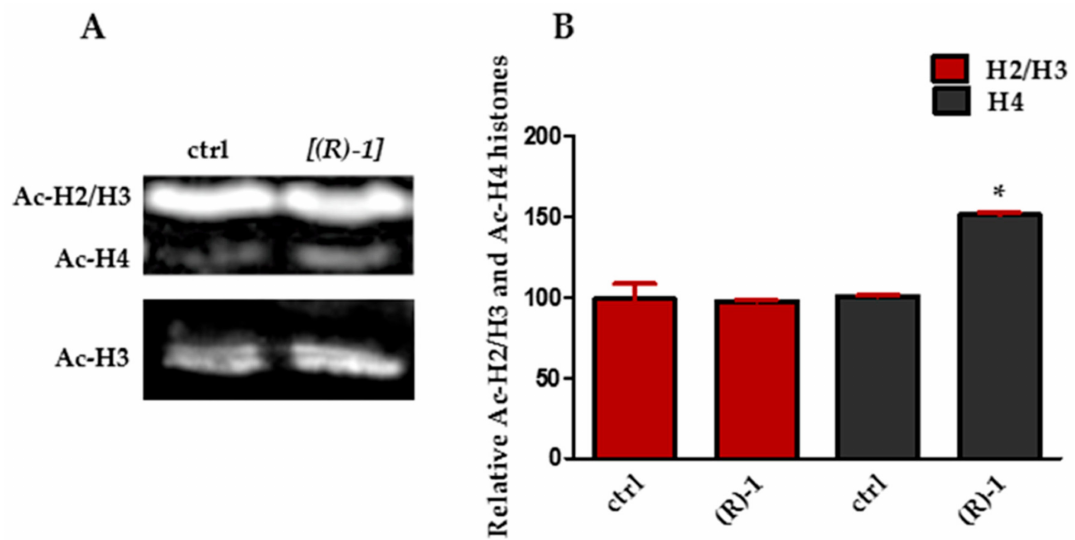
Figure 6. E ff ect of ( R ) - 1 on histone H4 acetylation. ( A ) The cells were cultured for 6 h in the absence (control) or presence of 49 µ M ( R ) - 1 . The cell nuclear extracts were prepared and subjected to a western blot analysis for acetylated (ac) histone H2 / H3, histone H4 and histone H3 as loading controls. ( B ) A representative experiment, repeated three times with similar results and densitometric analysis of the bands (mean ± SEM; n = 3), are shown. * p <